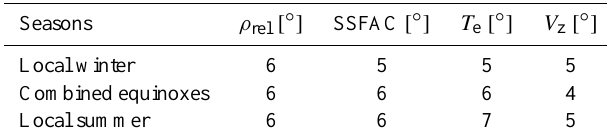
Table 1. The full latitudinal width at half maximum (FWHM)